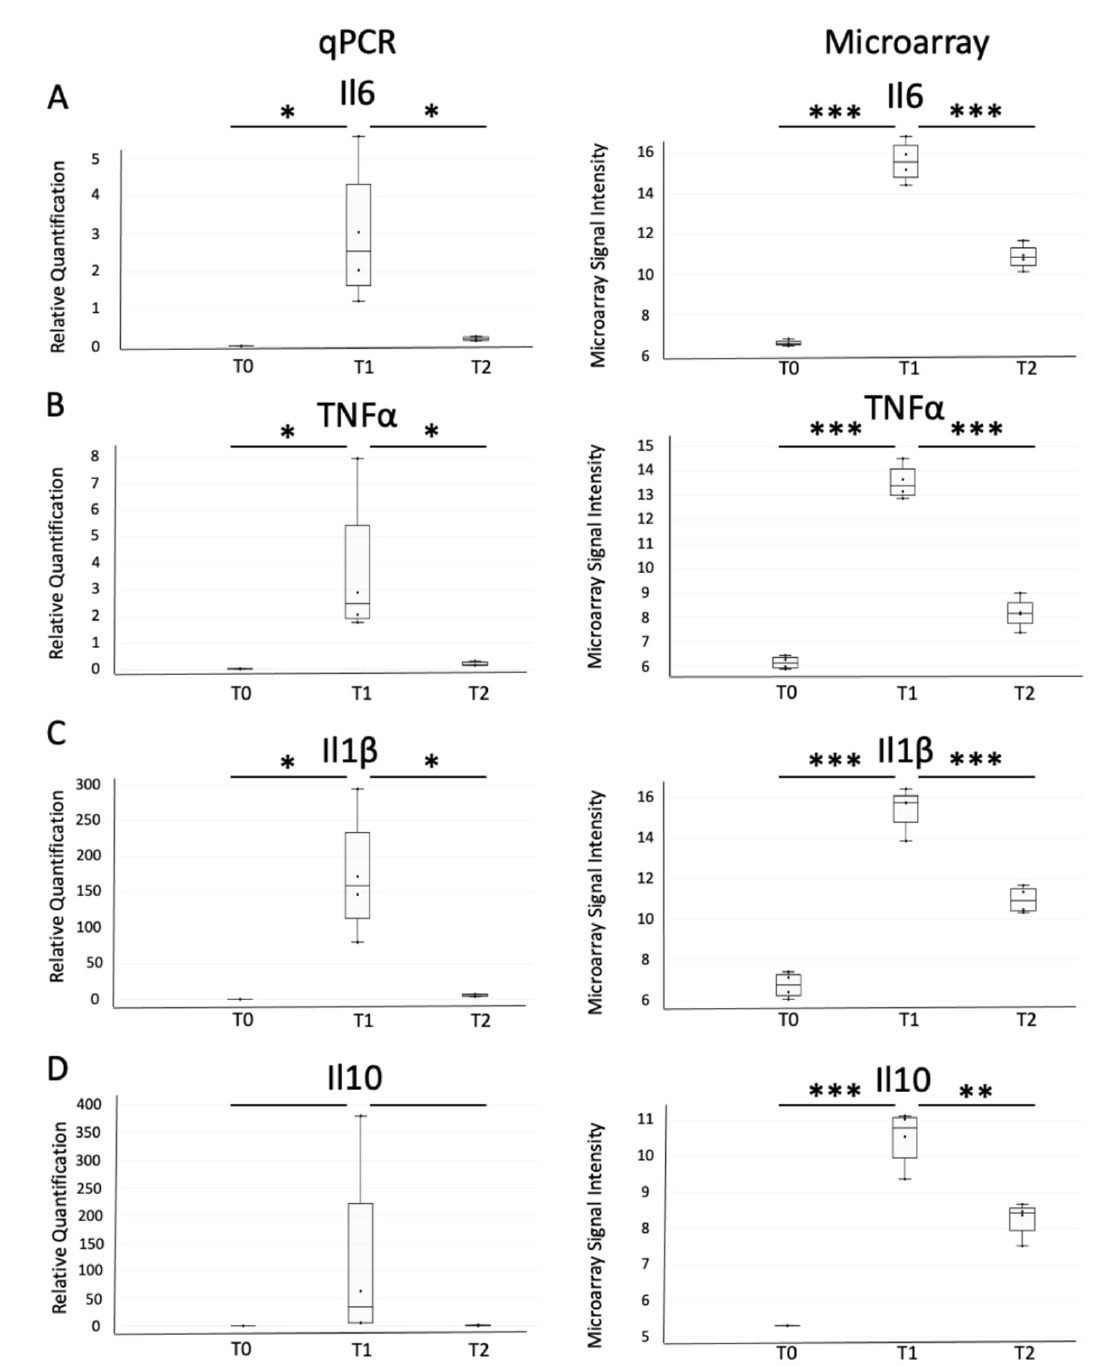
Figure 4. Expression levels of IL6 ( A ), TNF α ( B ), IL1b ( C ), and IL10 ( D ) measured by RT-qPCR ( left ) and with microarray ( right ). For RT-qPCR, values were normalized with the actin transcript. * p -value < 0.05, ** p -value < 0.01 and *** p -value < 0.001.